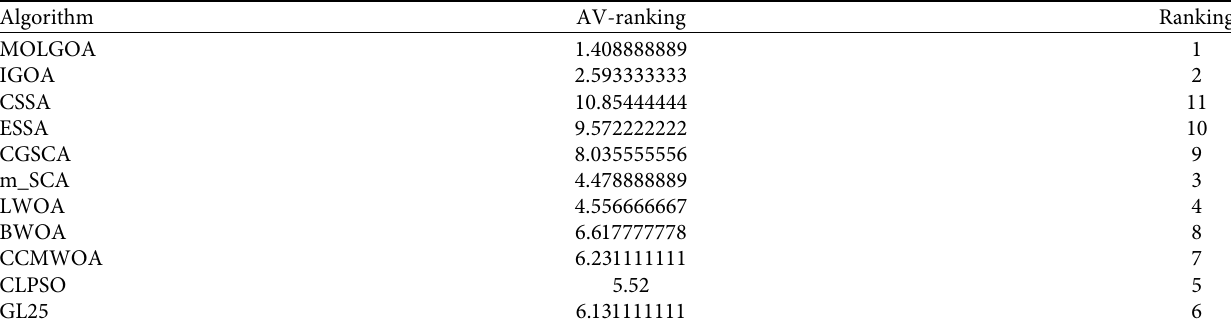
Table 10: Average ranking values of the Friedman